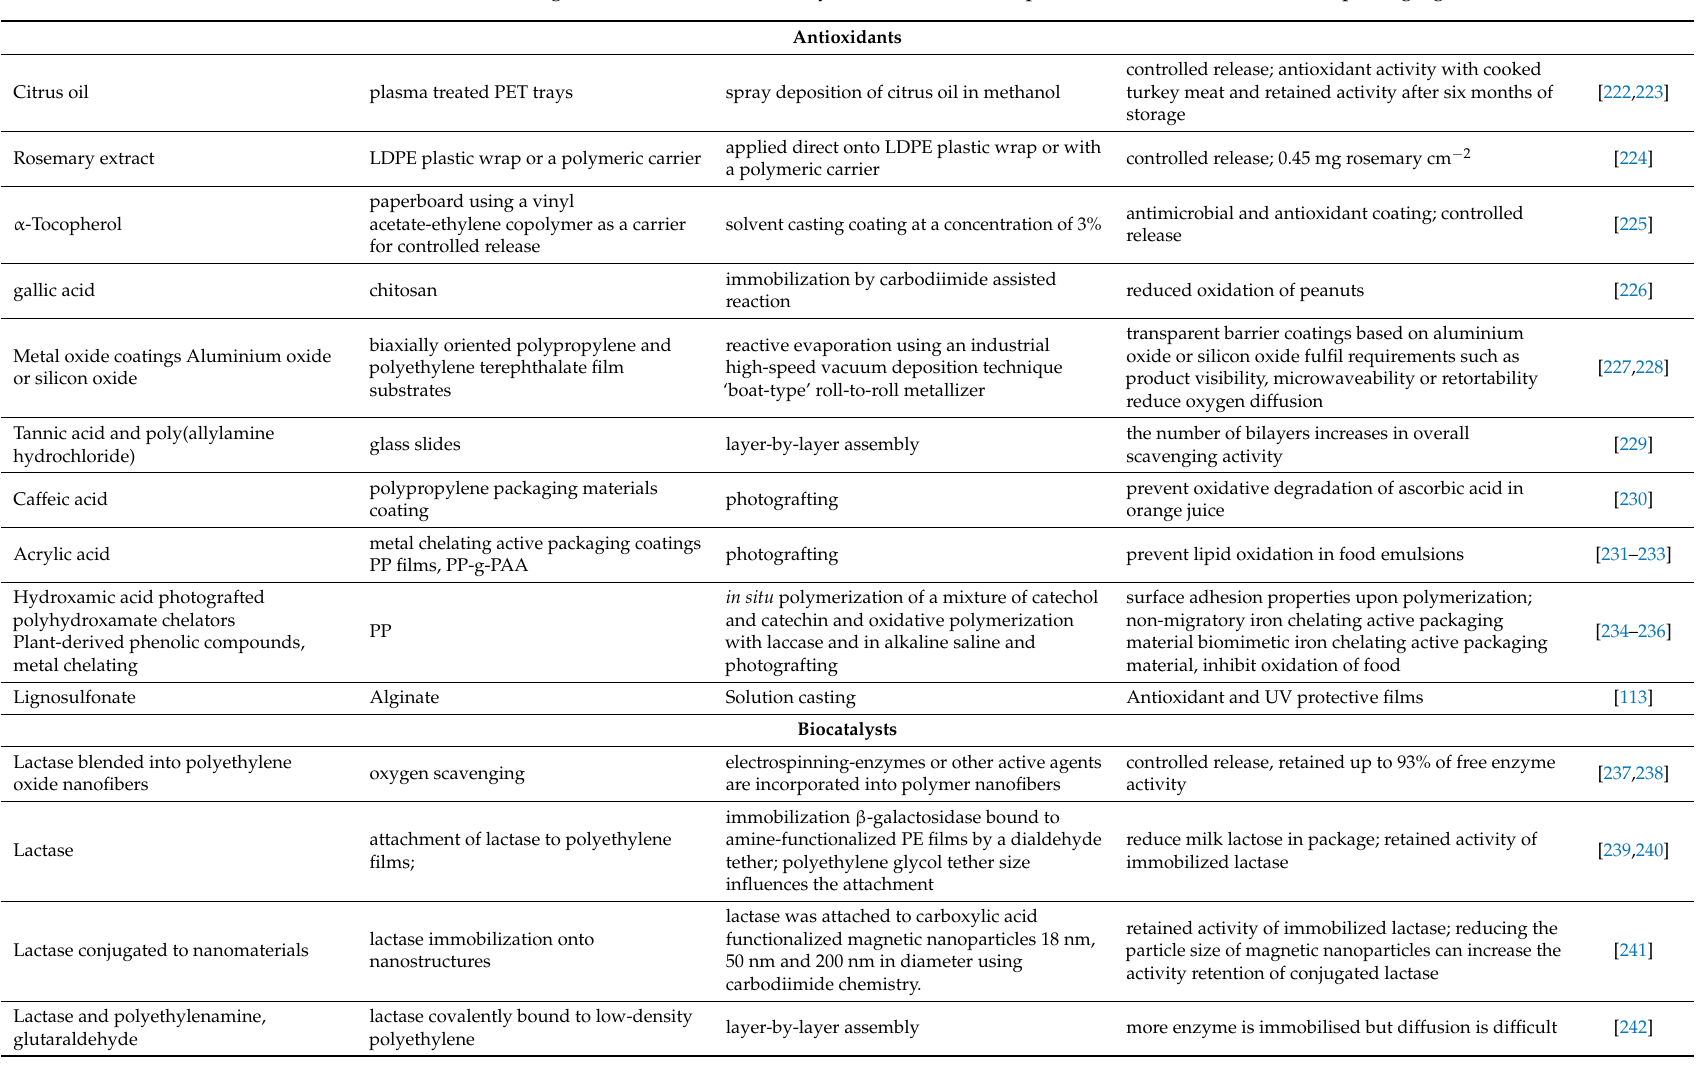
Table 4. Formulations including antioxidants and biocatalysts as bioactive compounds intended to use in food